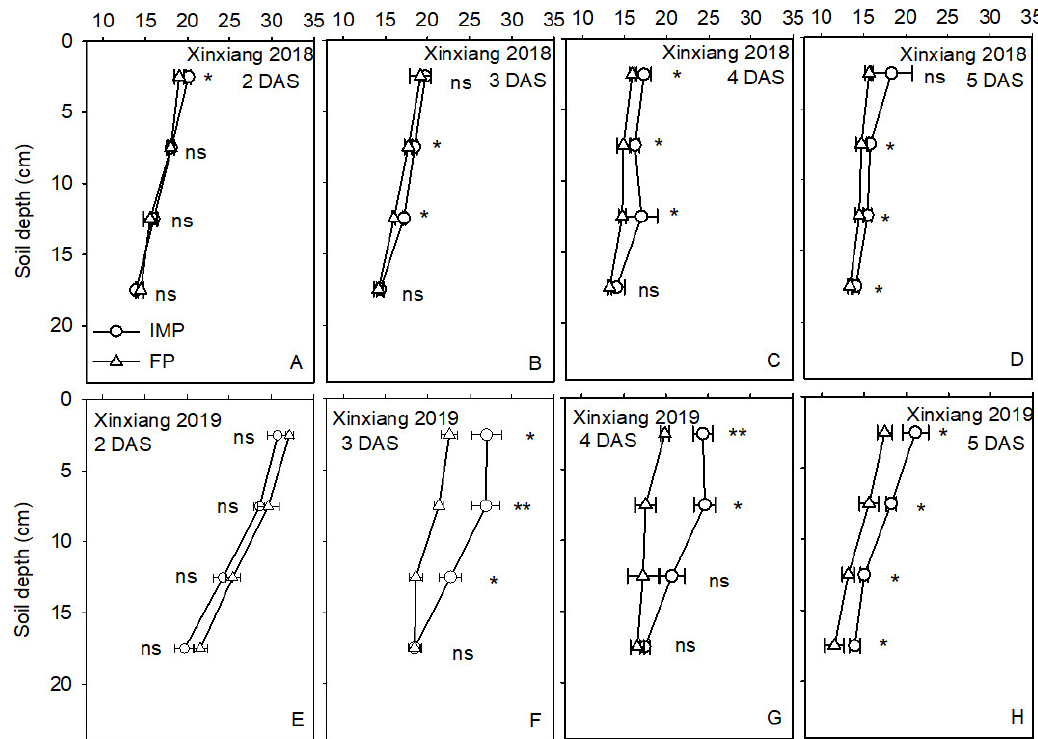
Figure 3. The effects of seeding management practices on relative water content in the top 0–20 cm of the field in Xinxiang site. DAS, day after seeding. IMP, integrated management practice; FP, farmers’ practice. * and **, indicate significance different at the 0.05 and 0.01 probability levels, respectively, while ns indicates not significantly different. The left and right bars of each dataset represent standard error. ( A – D ) and ( E – H ) represent relative water content of soil at Xinxiang site in 2018 and 2019, respectively.